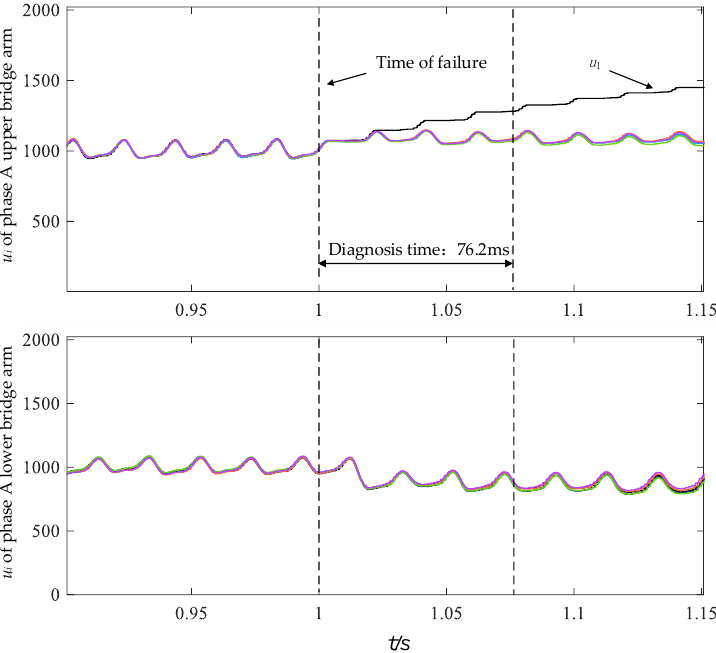
Figure 14. Simulation waveform of SM 1 S 1 open-circuit fault localization.